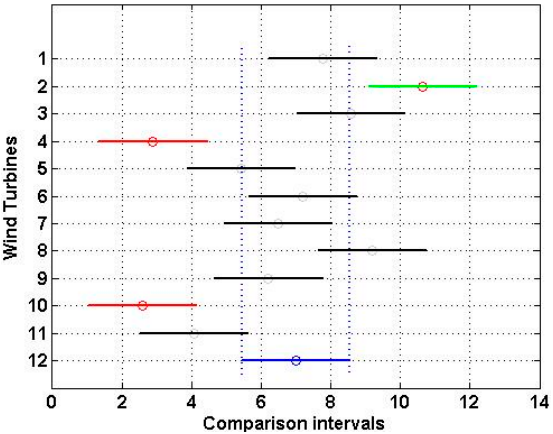
Figure 7. Multiple comparison of the power performance of the wind turbines at the (cid:2009) = 0.01 significance level. WT1: Wind Turbine 1 (Black); WT2: Wind Turbine 2 (Green); WT3: Wind Turbine 3 (Black); WT4: Wind Turbine 4 (Red); WT5: Wind Turbine 5 (Black); WT6: Wind Turbine 6 (Black); WT7: Wind Turbine 7 (Black); WT8: Wind Turbine 8 (Black); WT9: Wind Turbine 9 (Black); WT10: Wind Turbine 10 (Red); WT11: Wind Turbine 11 (Black); WT12: Guaranteed Power Curve (Blue).